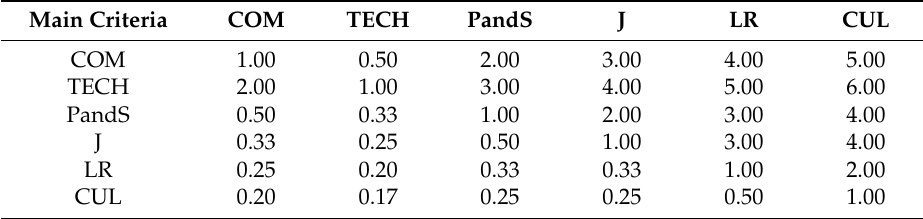
Table 3. Binary comparison matrix for main criteria .